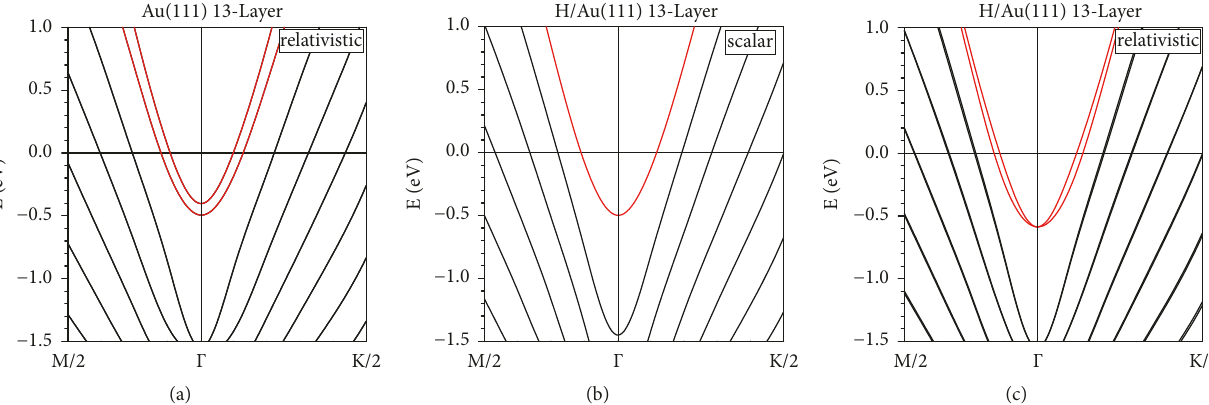
Figure 4: Band structures of the 13-layer Au(111) slab (a) and the slab with H overlayer (b, c), calculated in semirelativistic (b) and full relativistic (a, c)